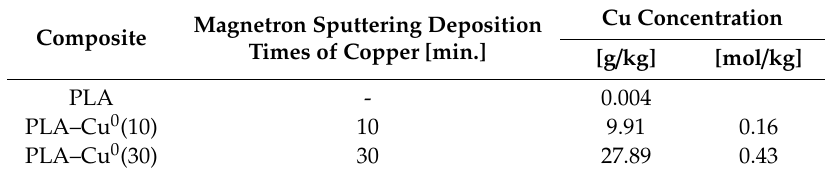
Table 8. Results of determination of copper content in PLA composite samples.